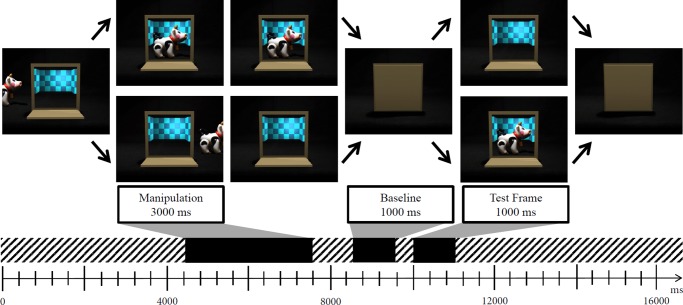
Depiction of animated stimuli and experimental design.